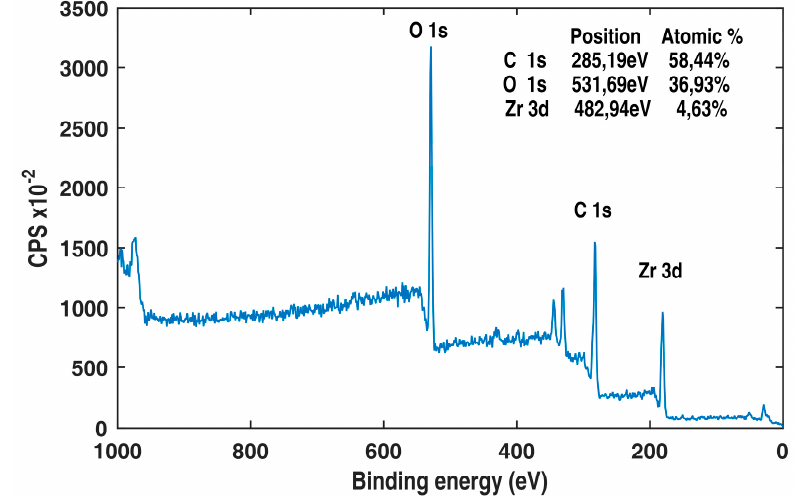
Figure 3. X-ray photoelectron spectroscopy (XPS) of a cotton fabric functionalized with UiO-66.